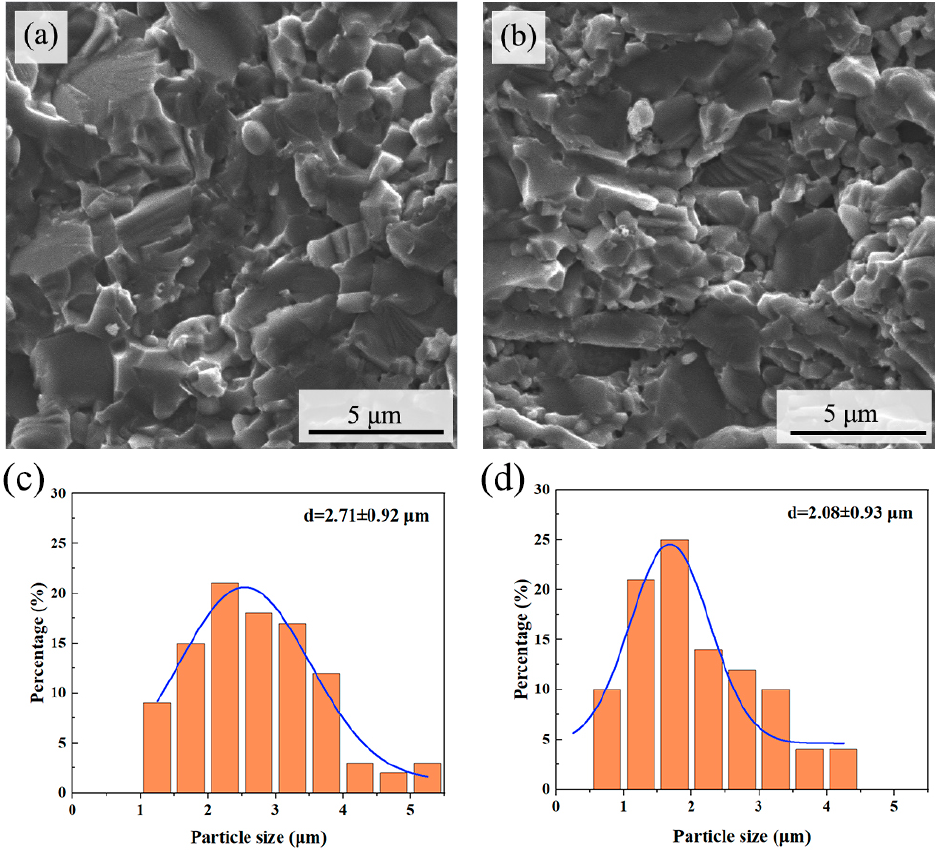
Figure 1. SEM images of the two ceramic cutting tools ( a ) ATS, ( b ) ATSC10; and particle size distribution ( c ) ATS and ( d ) ATSC10. The blue line is a Gaussian fitting curve, which reflects the general trend of particle size distribution. Table 3. Mechanical properties of ceramic tool materials.